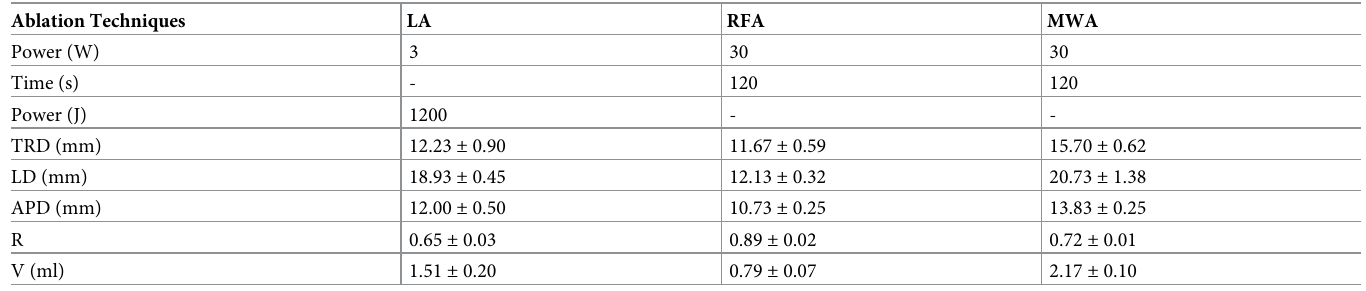
Table 1. Comparing the shape (R) and volume of ablation lesions created via LA, RFA, and MWA. Ablation